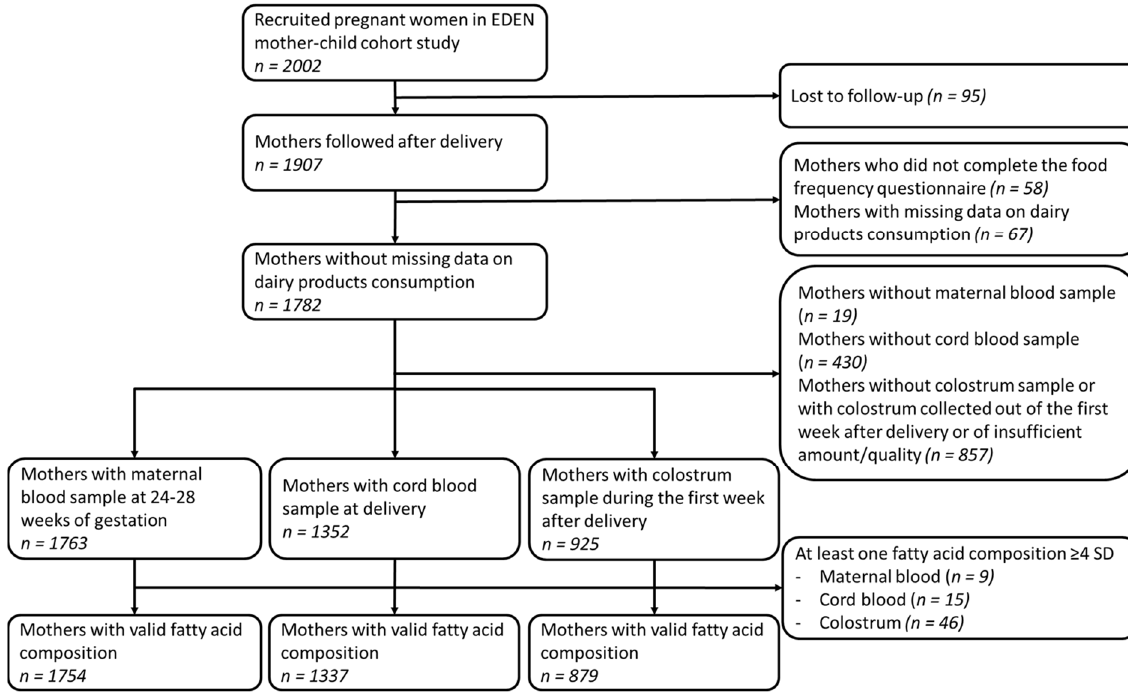
Figure 1. Sample selection flow